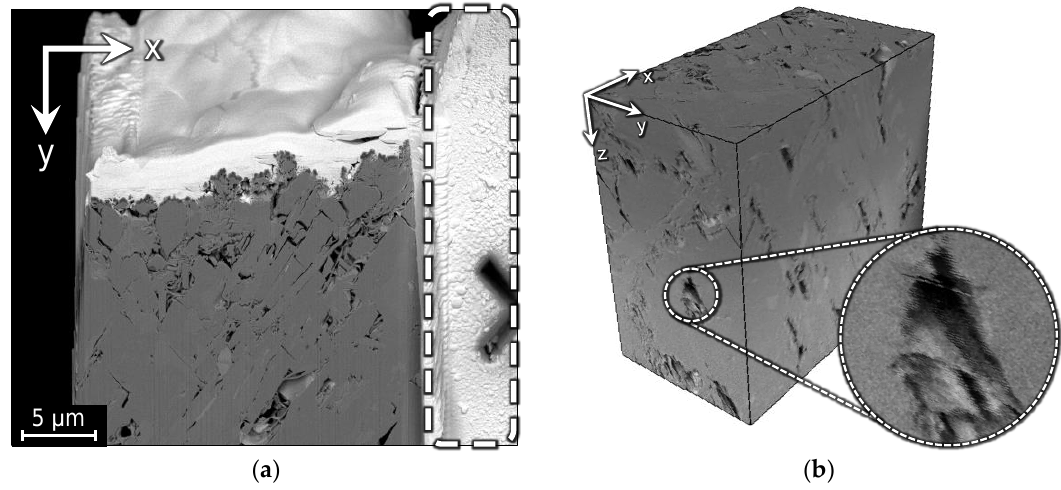
Figure 4. Image B: ( a ) a slice in the XY-plane including unchanged fragment outlined by the dashed line; ( b ) 3D visualization of the cropped region and enlarged fragment demonstrating misalignment in the XY-plane, which looks like shifted rows and ragged edges in the XZ and YZ side views.